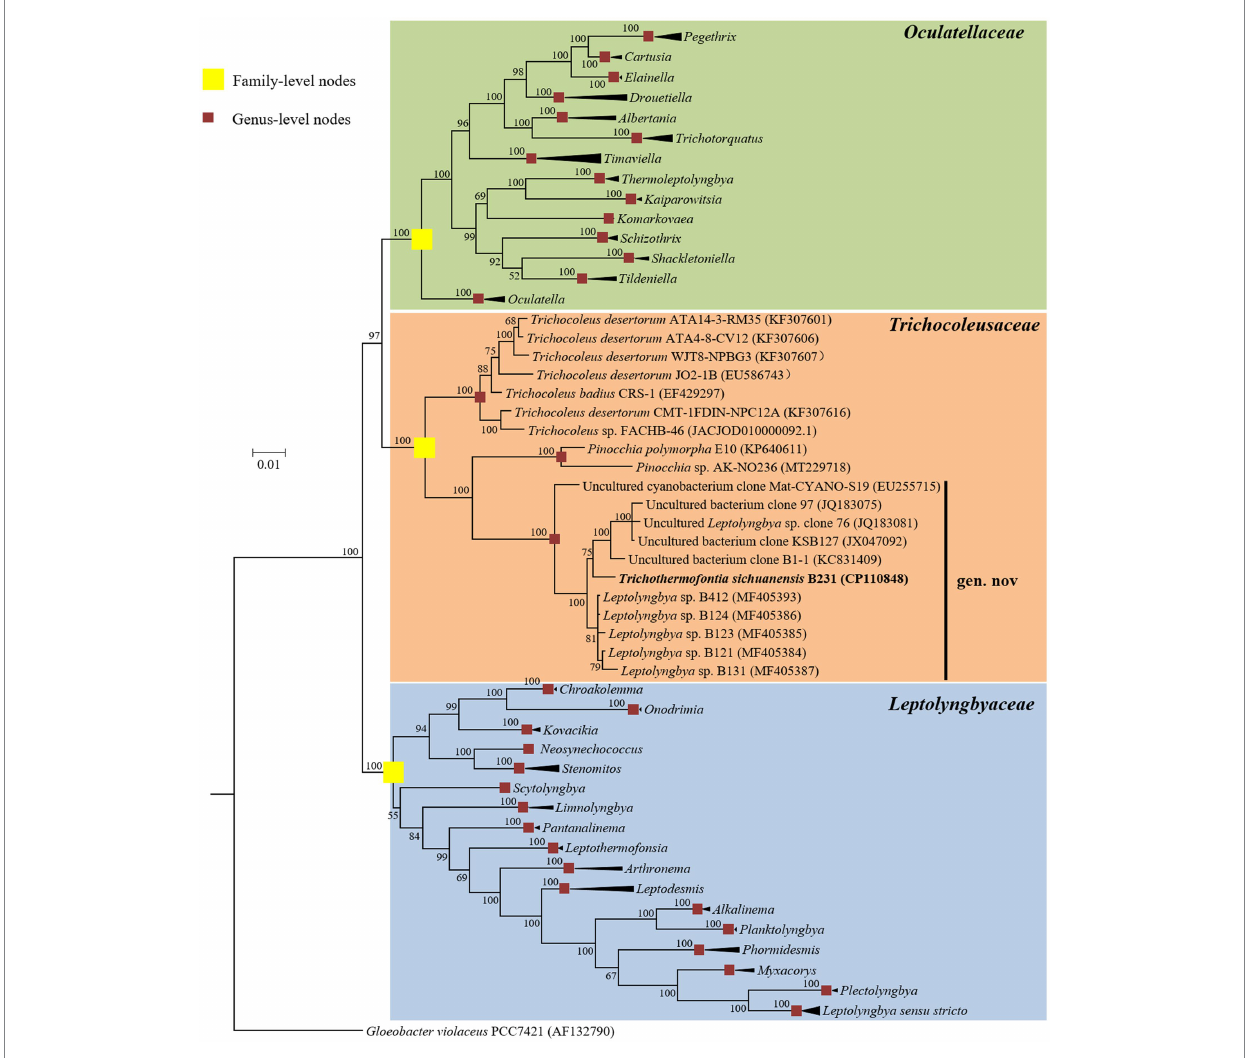
Supplementary Figure 1. Posterior probabilities (%) are given above the